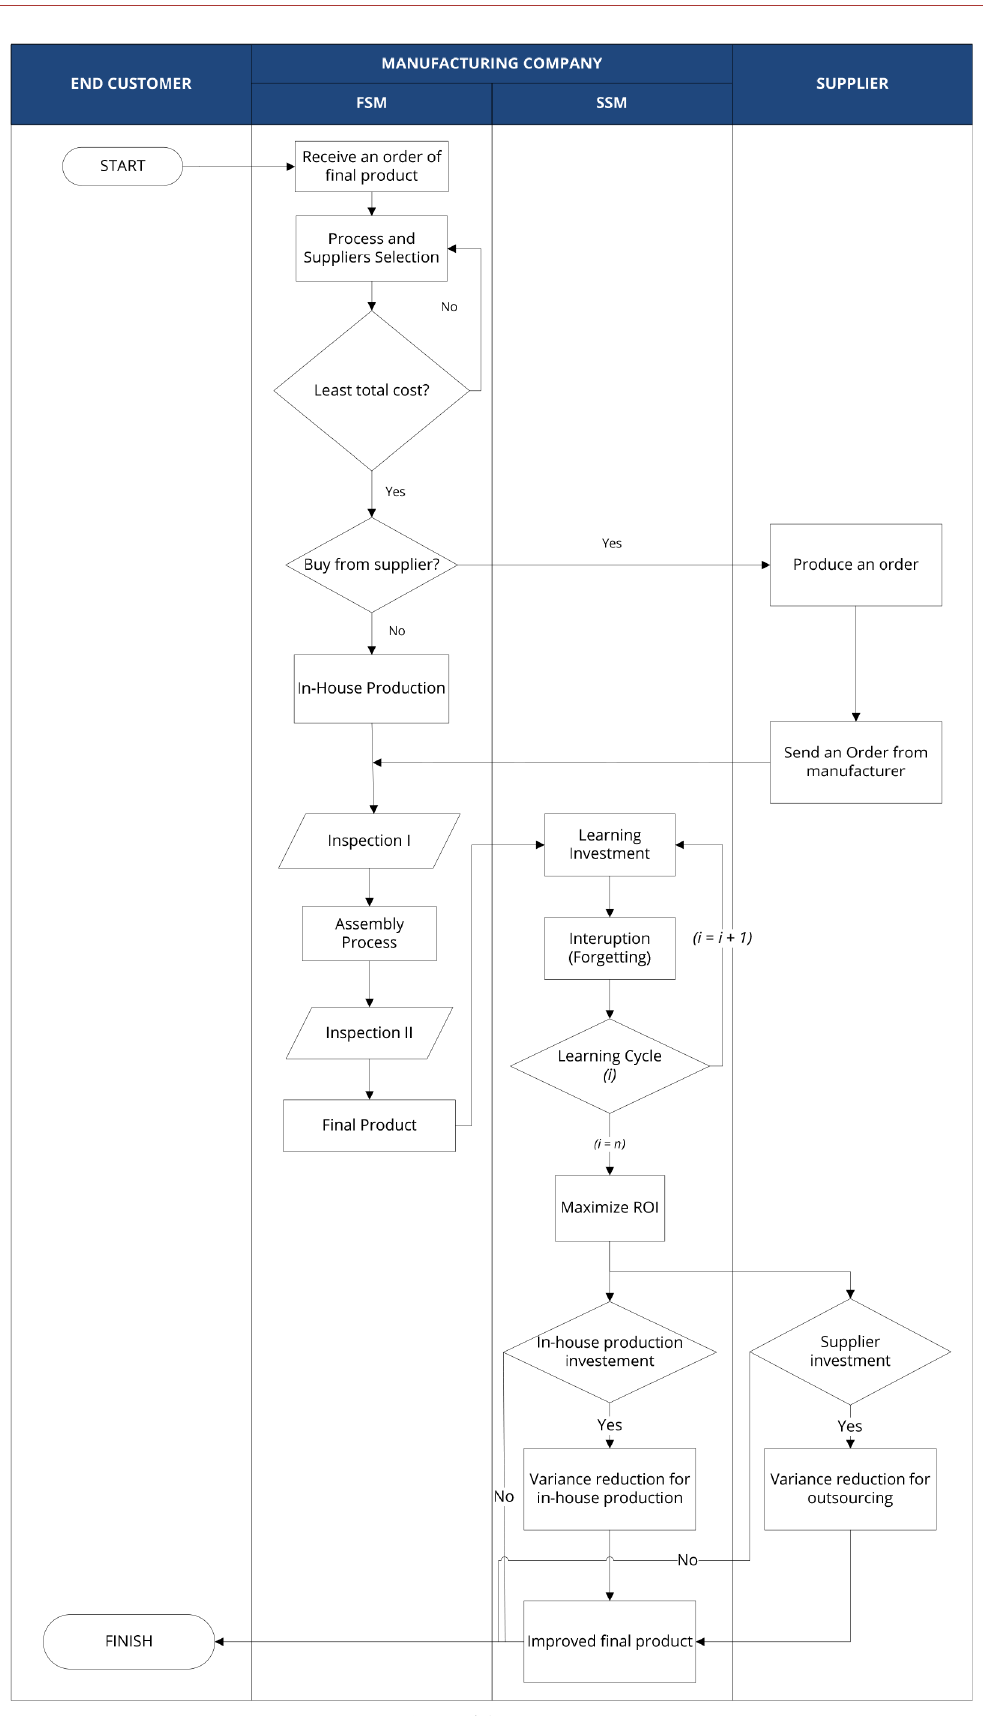
Figure 1. General System